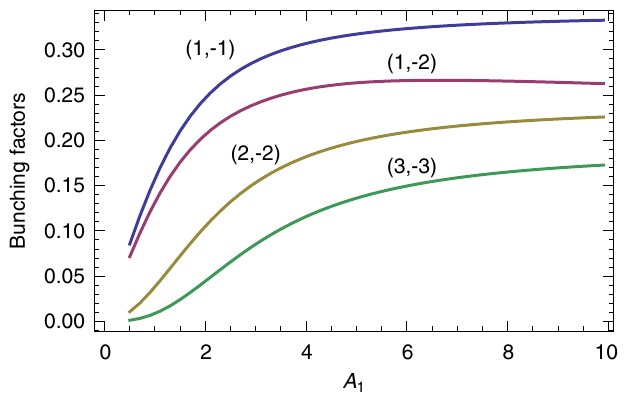
FIG. 3. (Color) The maximized bunching factors b 1 ; (cid:2) 1 , b 1 ; (cid:2) 2 , b b 2 ; (cid:2) 2 , and 3 ; (cid:2) 3 as functions of the modulation amplitudes The pairs ð n; m Þ for each curve are shown in the picture. each harmonic are defined as h½ N ð z Þ =N 0 (cid:4) e (cid:2) ik n;m z i , where the brackets denote averaging over the longitudinal coor- dinate z . After some mathematical manipulations the bunching factor is found to be independent of the laser phase difference and can be written as [12,13]